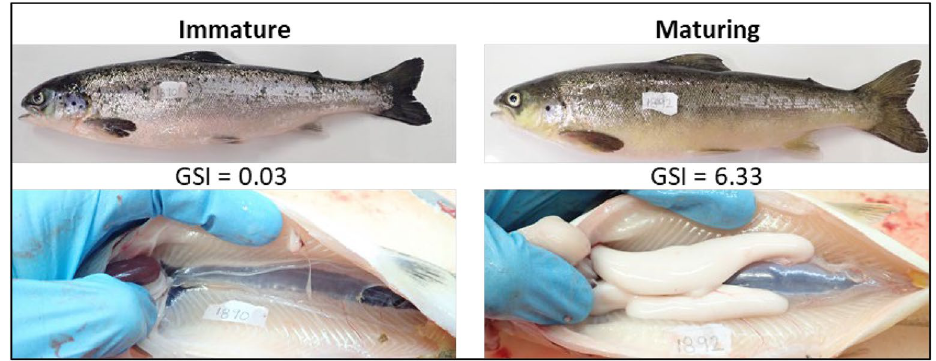
Figure 1. Typical examples of immature and maturing Atlantic salmon. Photographs showing the external appearance and gonads of fish classified as either immature (GSI < 0.8) or maturing. Photographs by Tina Oldham.